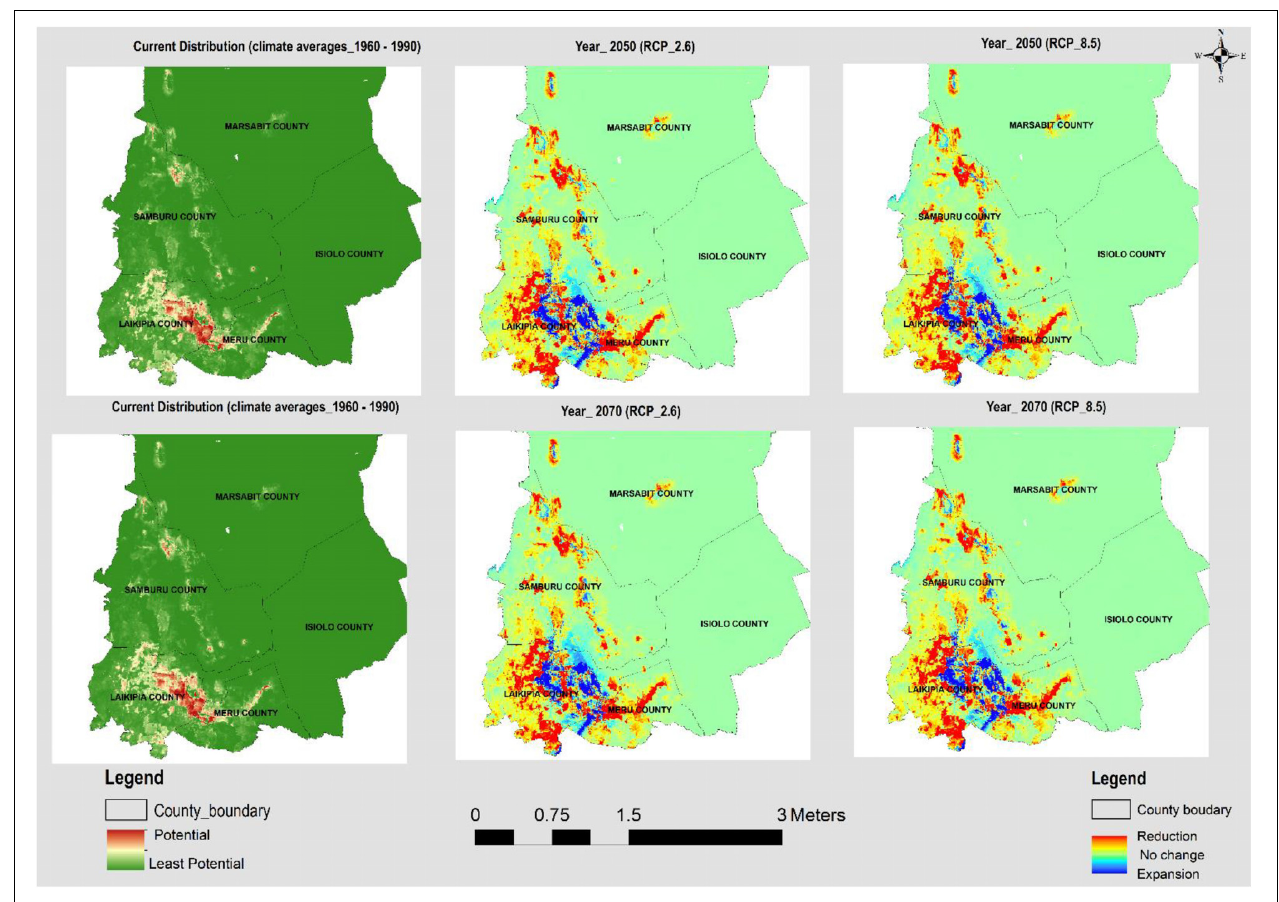
FIGURE 3 | The current and potential distribution under RCP 2.6 and RCP 8.5 for the years 2050 and 2070 for Opuntia